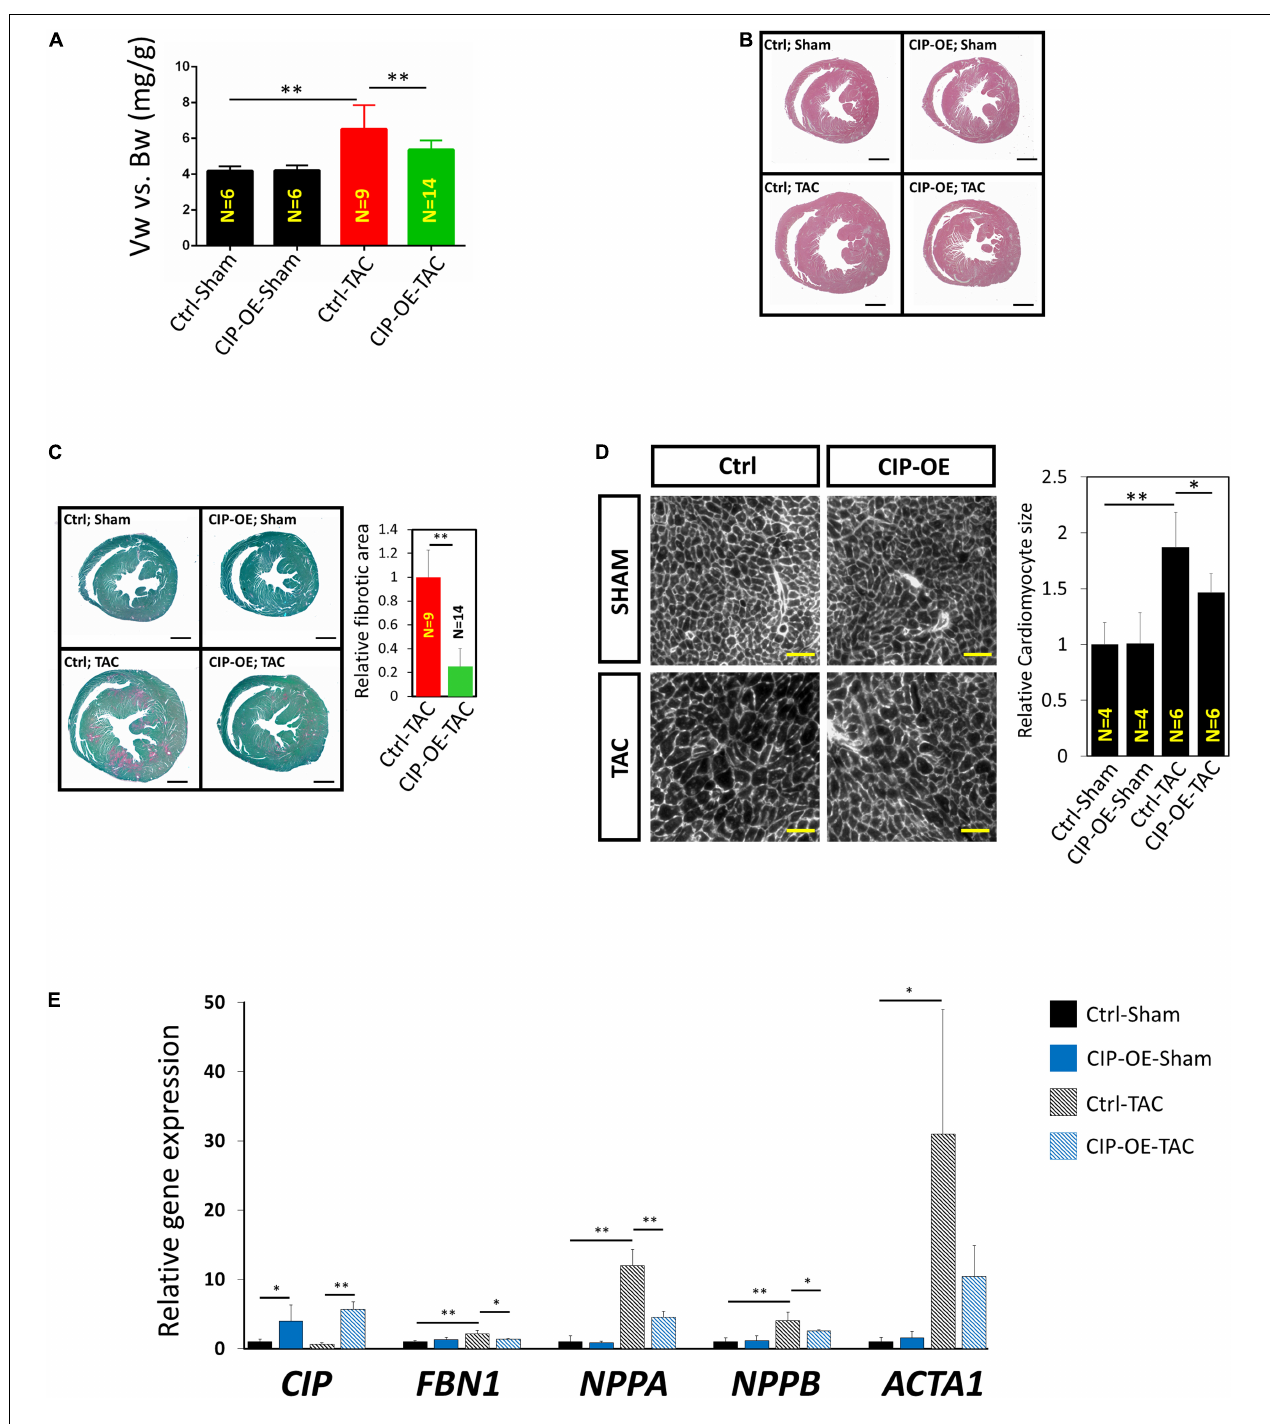
FIGURE 4 | Cardiac ISL1-interacting protein inhibits cardiac remodeling in the transition from cardiac hypertrophy to failure. (A) The ratio of ventricle weight vs. body weight of CIP-OE mice and their control littermates at 8 weeks after TAC or sham operation. N number of each group is shown. (B) Haematoxylin Eosin (H&E) staining of hearts from CIP-OE mice and their control littermates at 8 weeks after TAC or sham operation. Bars = 1 mm. (C) Fast green and Sirius red staining of hearts from CIP-OE mice and their control littermates at 8 weeks after TAC or sham operation. The fibrotic area was quantified. Bars = 1 mm. (D) Wheat germ agglutinin staining detecting the cross area of cardiomyocytes in TAC- or sham-operated CIP-OE hearts and littermate controls. The size of cardiomyocyte was quantified. Bars = 40 µ m. (E) qRT-PCR detection of expression of cardiac fibrosis and heart disease marker genes in TAC- or sham-operated CIP-OE hearts and littermate controls. N = 4 for each group. The significance between groups was tested with 1-way ANOVA with post hoc Tukey’s test. ∗ P < 0.05; ∗∗ P < 0.01.